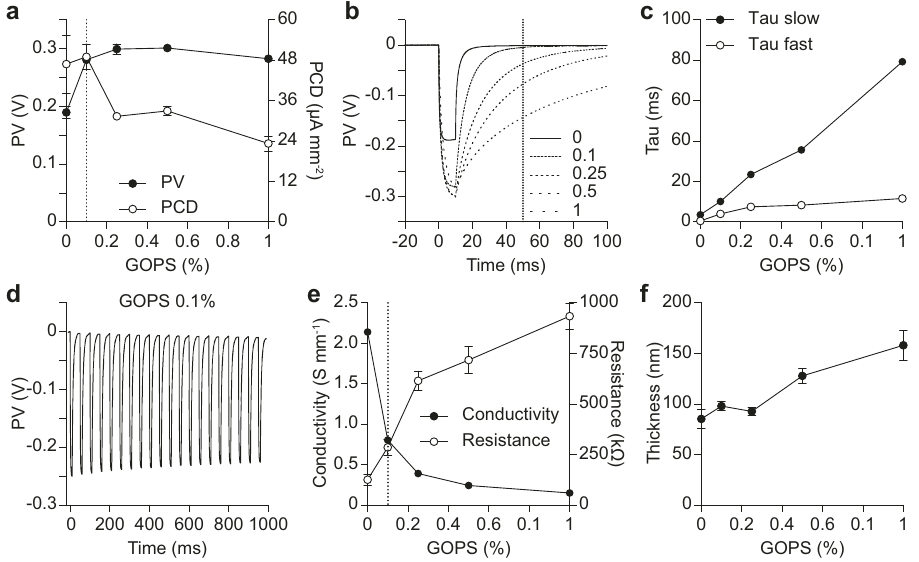
Fig. 5 Electrical tuning with the GOPS concentration. a Mean (±s.e.m.) PCD (right axis) and PV (left axis) obtained upon 10-ms pulses (730 nm, 6 mW mm − 2 ) with PH1000/PCPDTBT:PC 60 BM/Ti supplemented with various concentrations of GOPS (0, 0.1, 0.25, 0.5, 1 v/v%, n = 4 chips for each concentration). The vertical dotted line highlights the values at 0.1 v/v% of GOPS. b Grand-average ( n = 4 chips for each concentration) PV traces obtained at the same conditions as in a . The vertical dotted line shows the PV value 50 ms after the light onset. c Evolution of τ fast and τ slow as a function of the GOPS concentration. d Representative traces from a single electrode of PV upon 20 pulses (10 ms, 730 nm, 6 mW mm − 2 ) delivered at 20 Hz with PH1000 supplemented with 0.1 v/v% of GOPS. e , Mean (±s.d.; 12 measures from n = 2 samples for each condition) resistance (white circles, right axis) and average conductivity (black circles, left axis) of PH1000 fi lms with various concentrations of GOPS. The vertical dotted line highlights the values at 0.1 v/v% of GOPS. f Mean (±s.d.; 12 measures from n = 2 samples for each condition) thickness of PEDOT:PSS (PH1000) fi lms with various concentrations of GOPS.